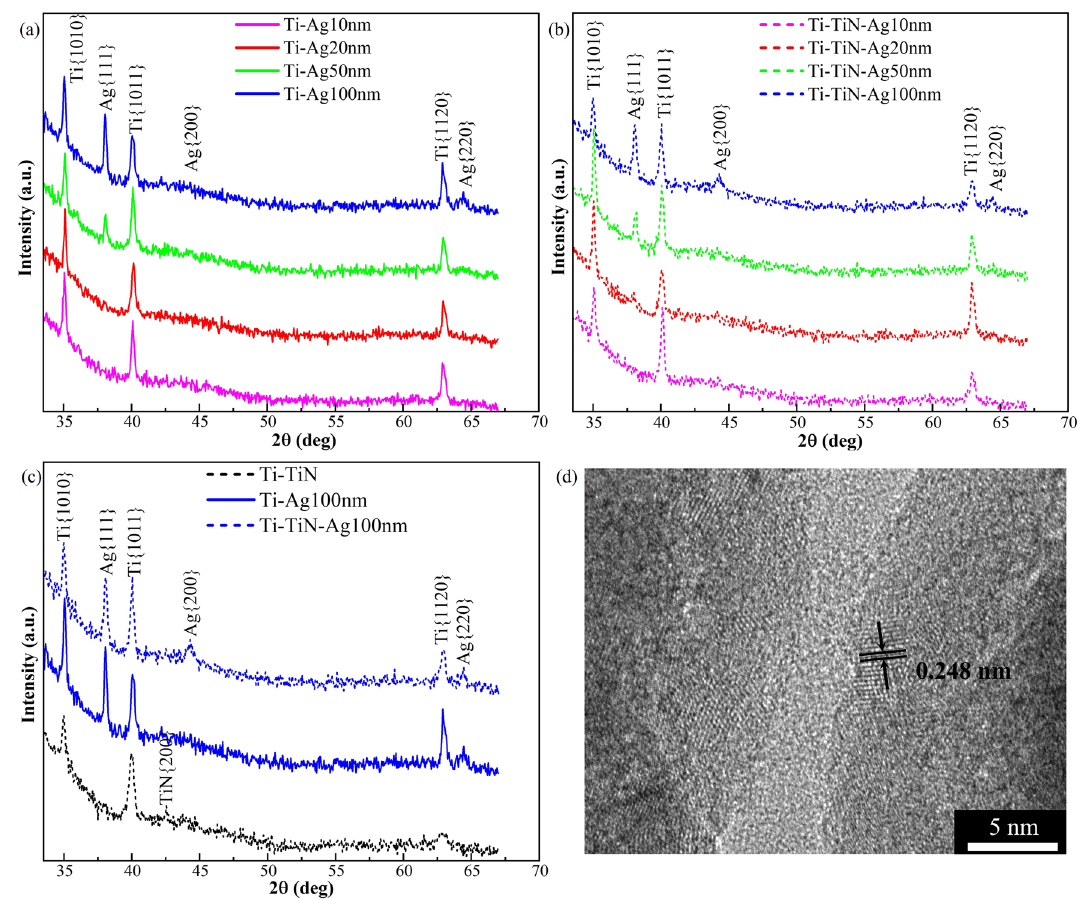
Figure 4. XRD intensity of nanorods ( a ) capped with Ag of 10, 20, 50, and 100 nm in thickness on Ti, ( b ) capped with Ag of 10, 20, 50, and 100 nm in thickness on Ti annealed for 4 h in N 2 , and ( c ) XRD